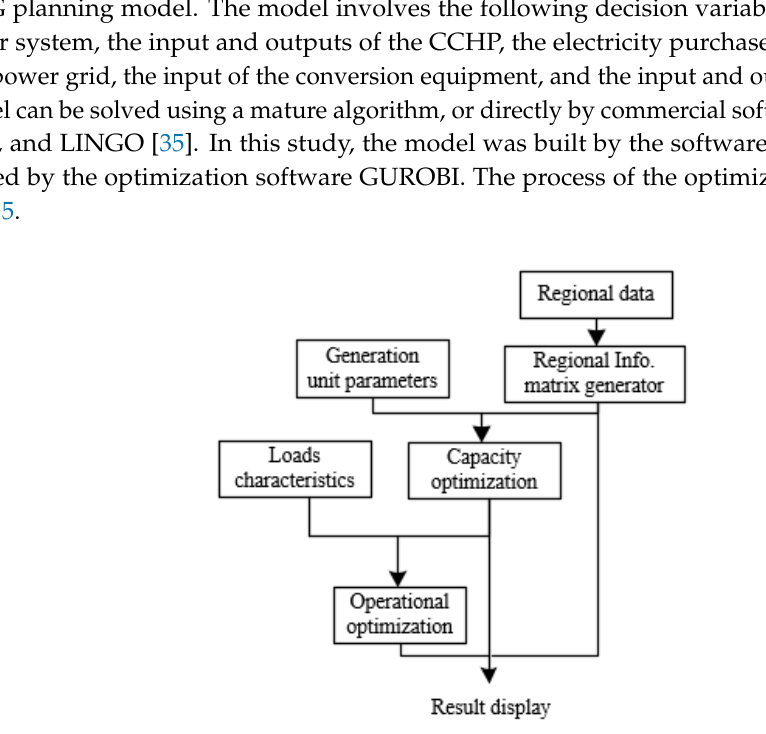
Figure 5. The optimization algorithm process of IEMG planning.